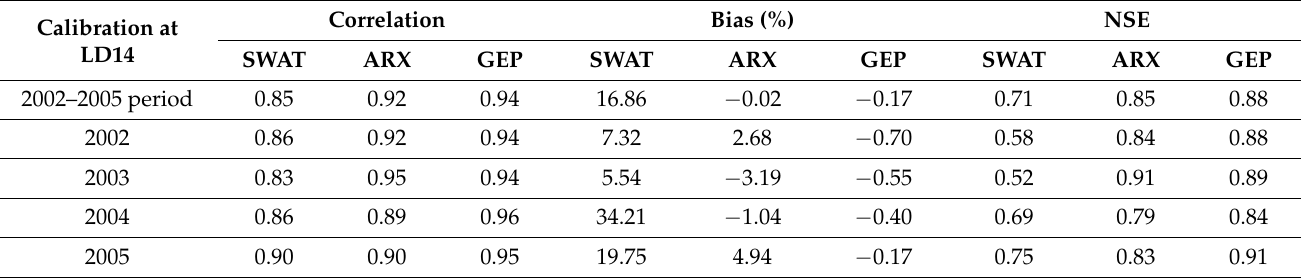
Table 3. Performance evaluation statistics of SWAT, ARX, and GEP model calibration